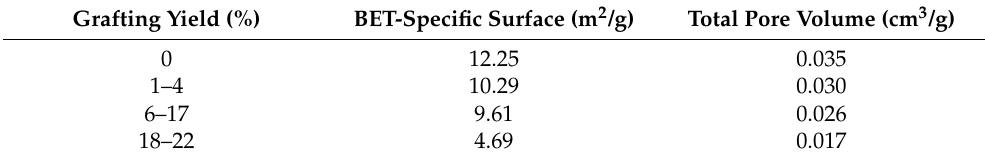
Table 2. BET-specific surface area and total pore volume of linear PNIPAm-grafted nylon